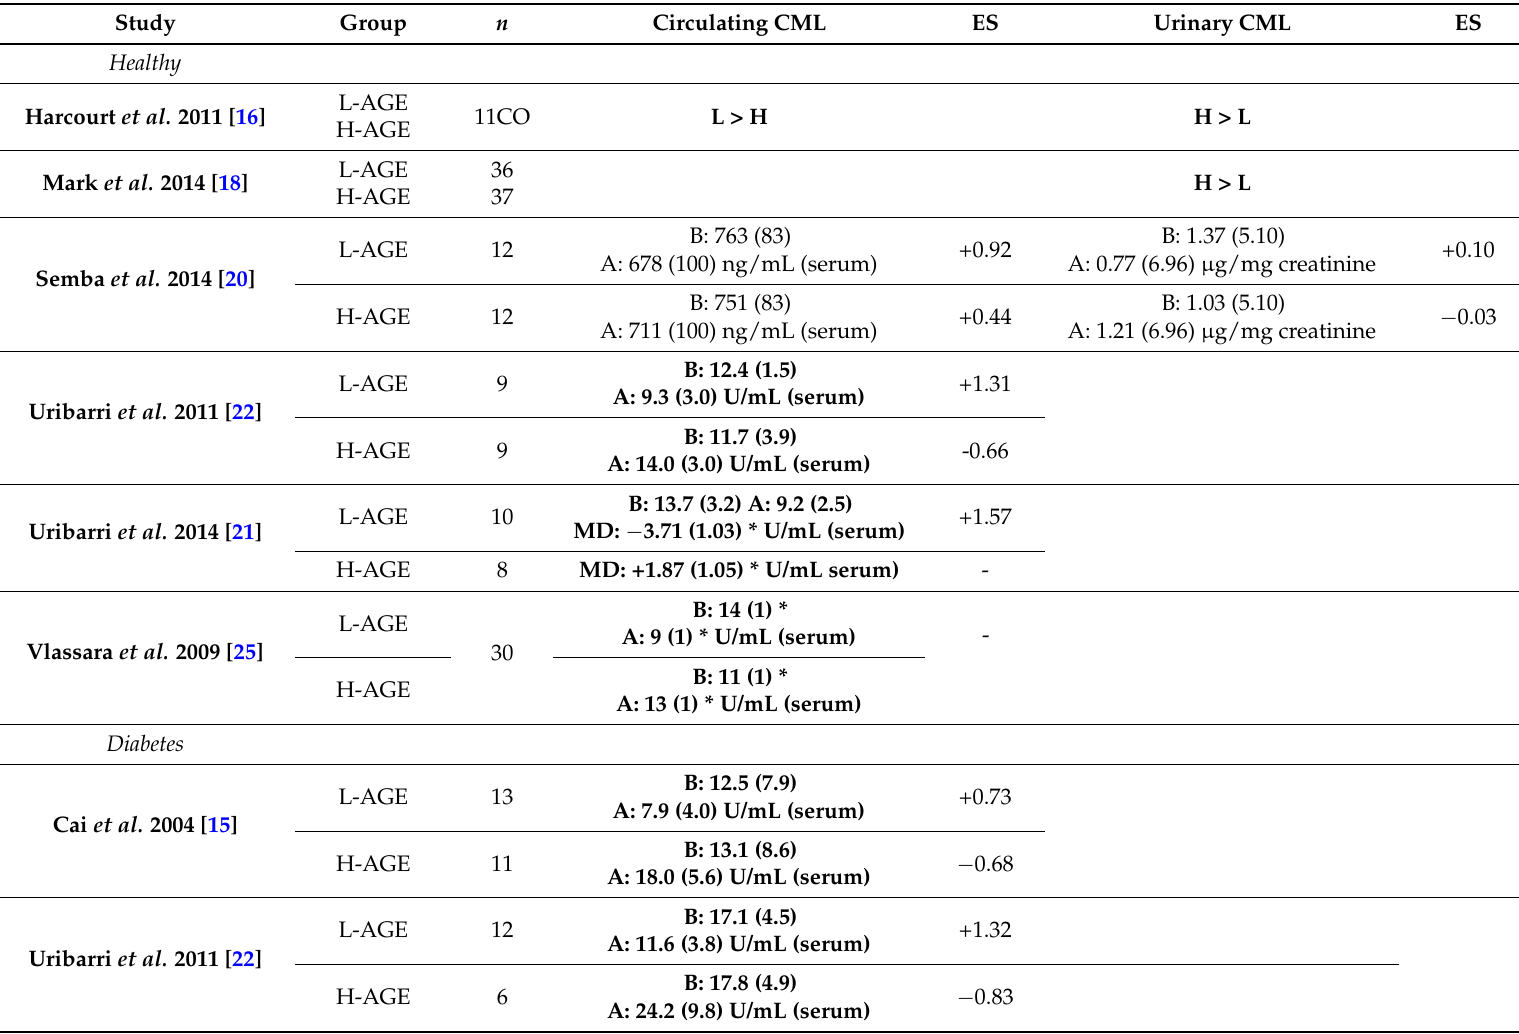
Table 4. Circulating levels and urinary excretion of the advanced glycation end-product Carboxymethyl Lysine